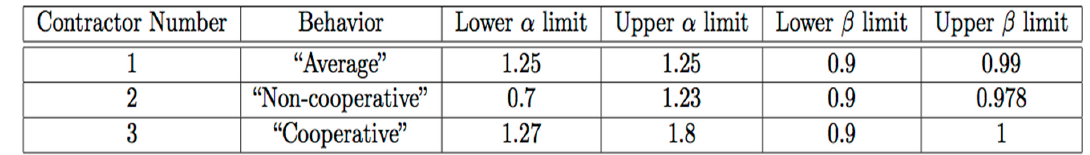
Figure 10. DAA-AWGE CPIF Optimal Bidder ∝ i and β i Limits